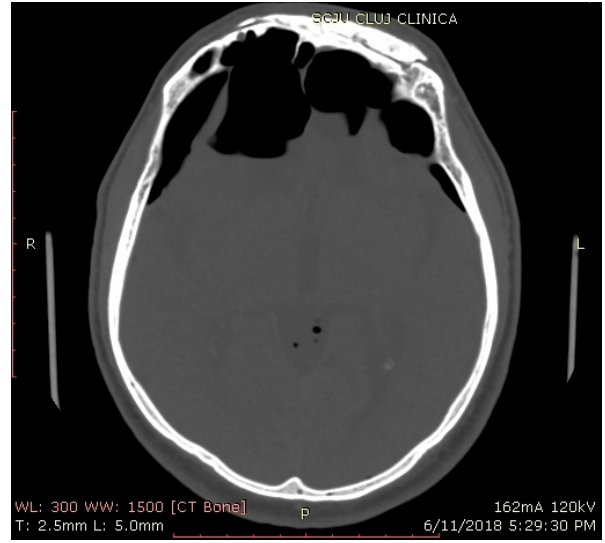
Figure 5. Cranial CT, axial plane, of a patient (no. 6) with tension pneumocephalus and visible Mt Fuji sign.